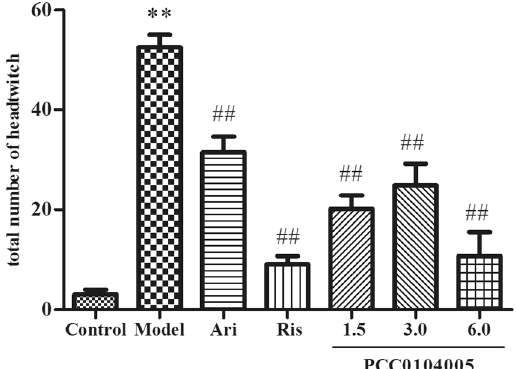
Figure 3. The effect of PCC0104005 on 5-HTP induced head twitches within 30 minutes. Rats were administered an oral dose of vehicle alone (0.5% methylcellulose, 1 ml/kg), PCC0104005 (1.5, 3.0, or 6.0 mg/ kg), aripiprazole (Ari, 1.5 mg/kg) or risperidone (Ris, 0.2 mg/kg) was orally administered 1 hour before the experiment. Twenty minutes later, 0.9% saline or 5-HTP (320 mg/kg) was intraperitoneally injected, and the total number of head twitches was recorded during a period of 40–70 min after intraperitoneal injection. Results are presented as mean ± S.E.M. (n = 8). * P < 0.05, ** P < 0.01 model group vs. the control group, # P < 0.05, ## P < 0.01 drug delivery groups vs. the model